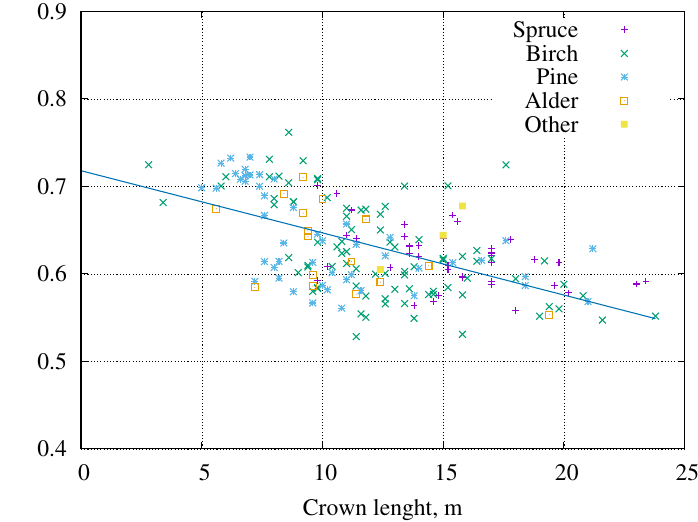
Figure 9. Crown length and clumping